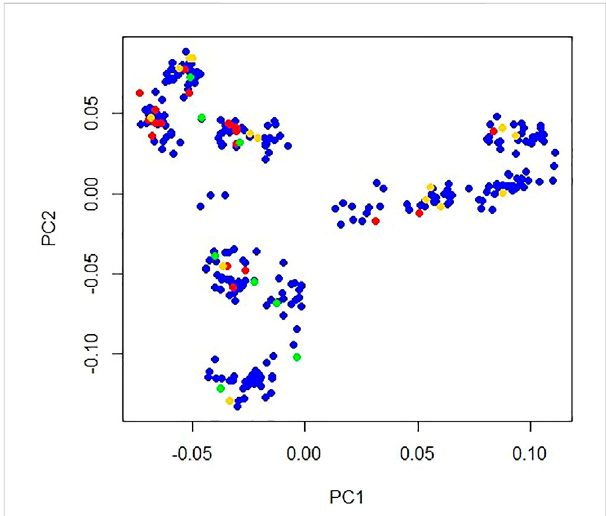
FIGURE 1 Population structure plot of Longyan Shan-ma duck. X -axis represents principal component 1 and Y -axis represents principal component 2. Blue dot indicates pockmarked feathers ( n = 261), red dot indicates one black feather ( n = 20), green dot indicates multiple black feathers ( n = 9), and gold dot indicates missing phenotype ( n = 13) on one side